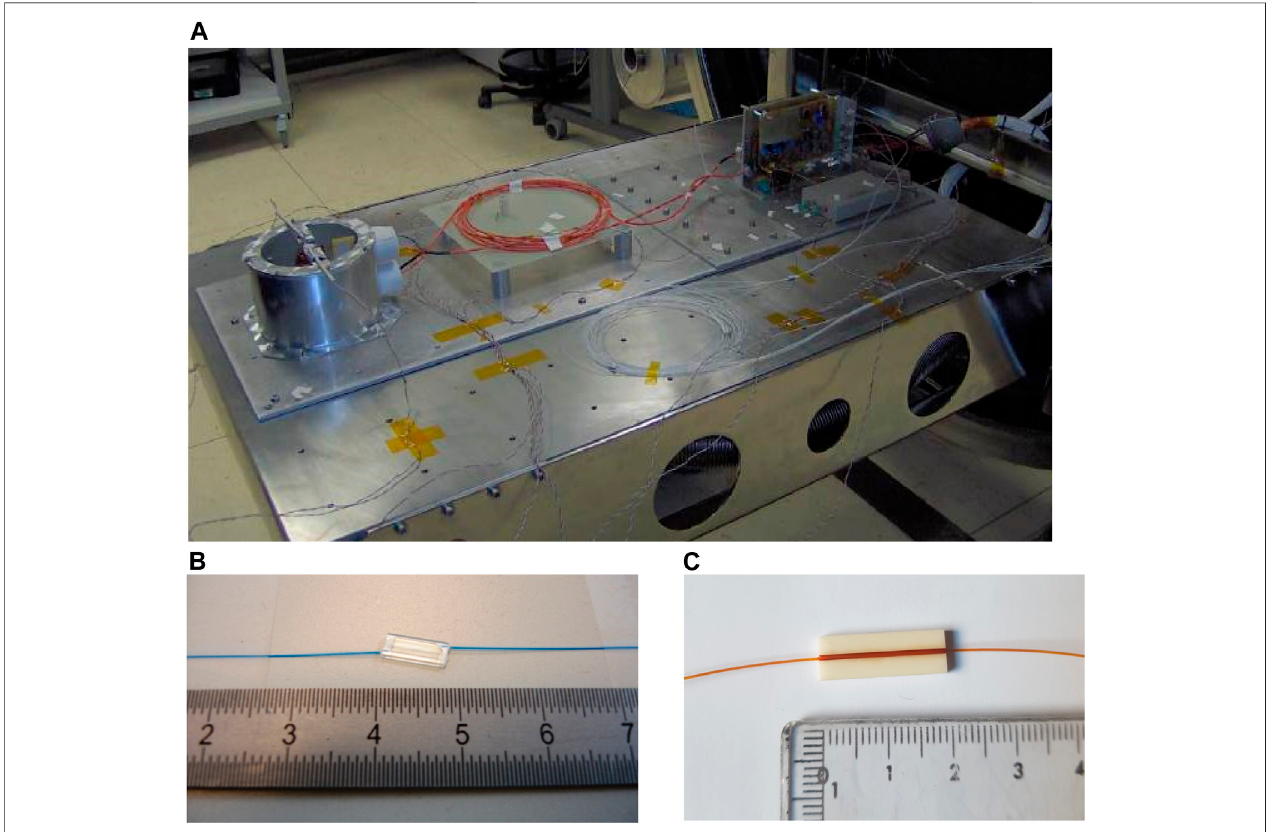
FIGURE4|(A) InstrumentedElectricPropulsionSystemMockupenteringthevacuumchamberfortesting, (B) MiniatureserialFBGdesignsbyHBMFiberSensing Design#1, (C) Design #2.